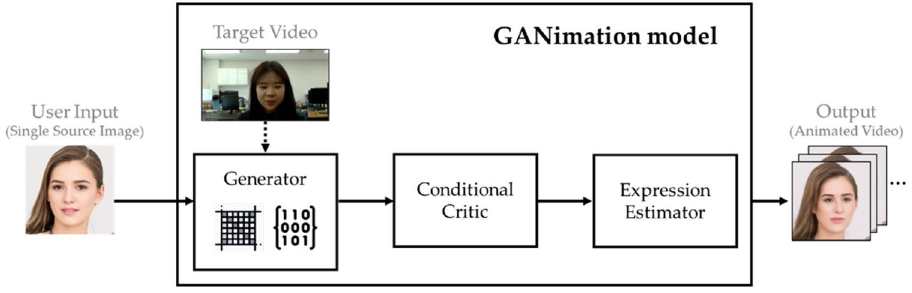
Figure 4. GANimation 36 in our evaluation framework.